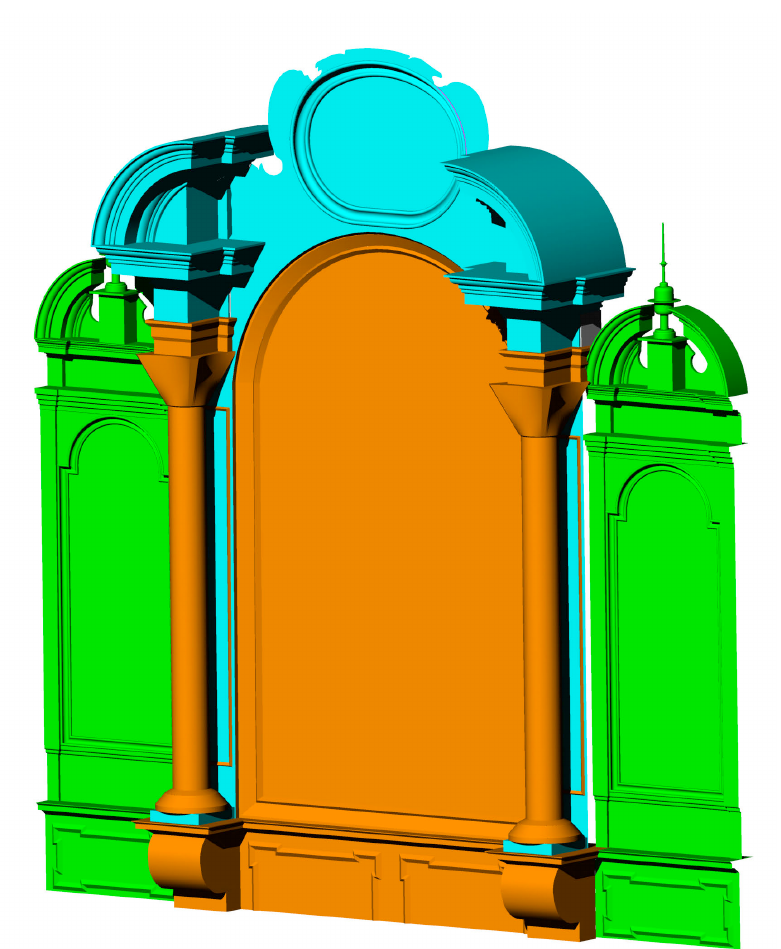
Figure 9: Perspective view of the final 3D model of the reconstructed altar